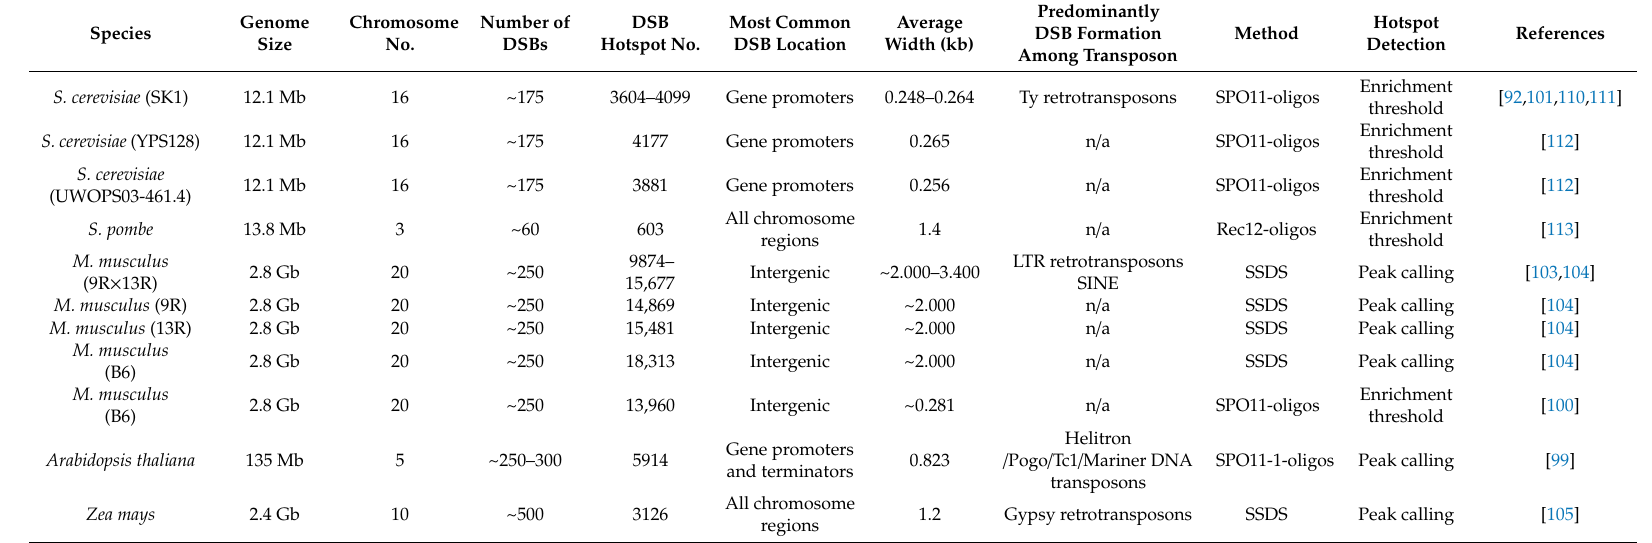
Table 2. Meiotic DSB hotspots identified in di ff erent species by SPO11-oligo mapping or single-stranded DNA sequencing